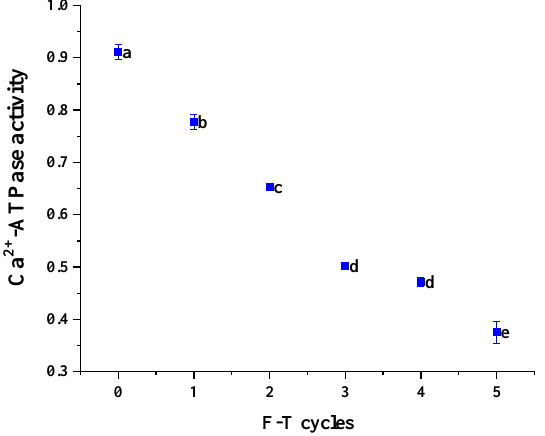
Figure 5. The Ca 2+ -ATPase activity of cuttlefish after freeze–thaw cycles. Error bars show standard deviation. The letters “a–e” indicate significant differences ( p < 0.05).